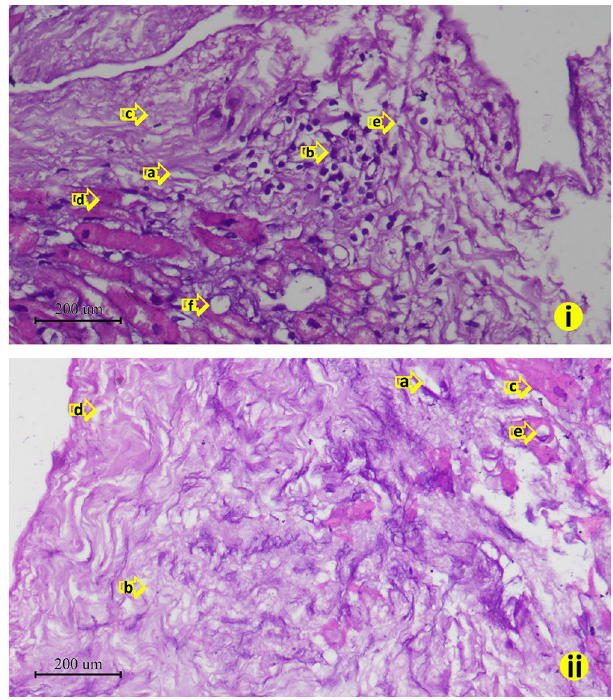
Figure 4. Comparative study of cardiac injury level in between patient from arsenic affected and un-affected area. (i) Patients who came from arsenic affected area showed higher level cardiac tissue injury ( a ) edema; ( b ) leukocyte infiltration; ( c ) fibrosis; ( d ) myocardial fiber swelling; ( e ) fiber separation; ( f ) fatty change than the (ii) patients who came from arsenic un-affected area ( a ) edema; ( b ) leukocyte infiltration; ( c ) fibrosis; ( d ) myocardial fiber swelling; ( e ) fiber separation (H and E stain. Captured in 40x). The default scale bar for each micrograph was set at 200